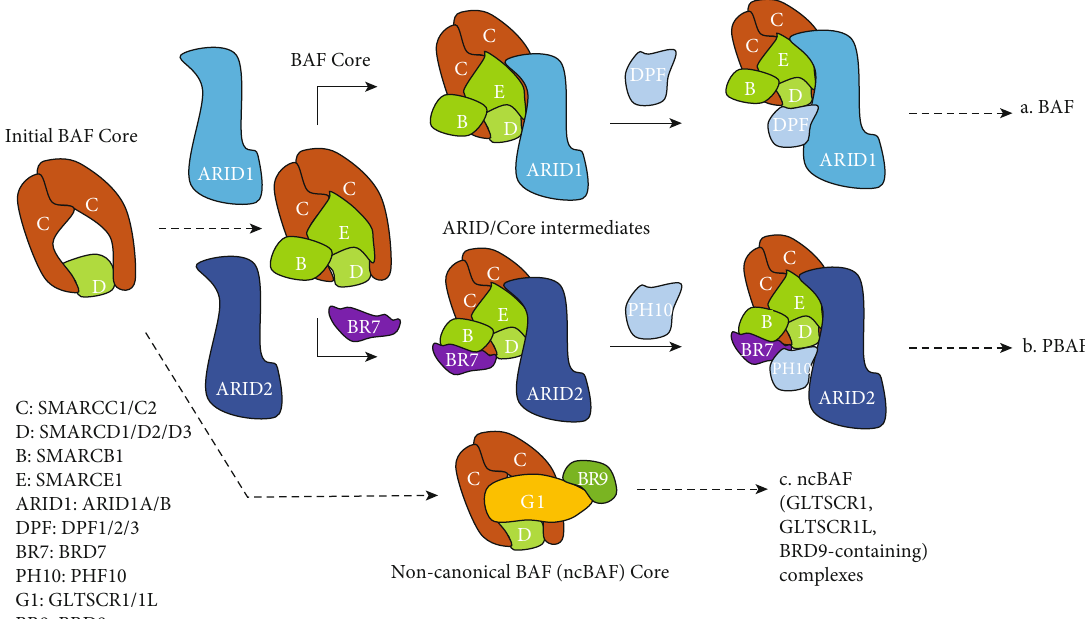
Figure 2: Three types of SWI/SNF assembly processes. (a) BAF: ARID1 and BAF core modules form a subcomplex (ARID1/BAF core), then combine with DPF2, and recruit ATPase modules (including SS18) to complete BAF assembly; (b) PBAF: ARID2 fi rst combines with BAF core to form a subcomplex (ARID2/PBAF core), then combines BRD7 and PHF10, followed by the recruitment of ATPase module (excluding SS18), and fi nally combines with PBRM1 to complete PBAF assembly; (c) ncBAF: GLTSCAR1/1L BRD9 combines with BAF core module to form the core module of ncBAF and combines BRD9 with ATPase module (containing SS18) to form the ncBAF complex [25, 26].